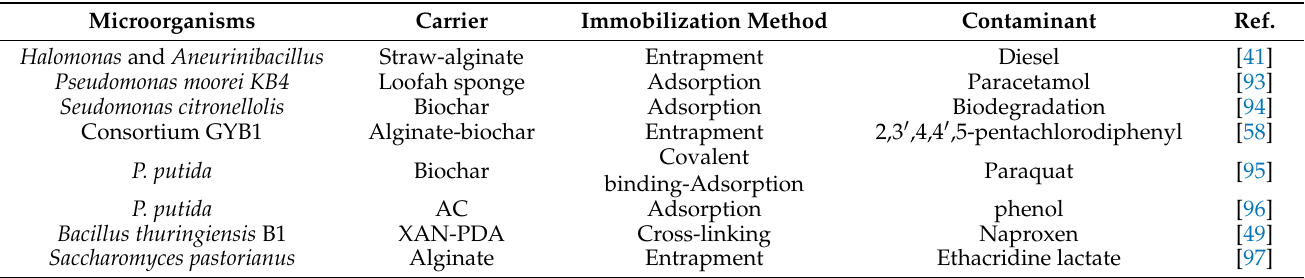
Table 2. Application of immobilized microorganism in the treatment of refractory organics contami- nants contained in waste